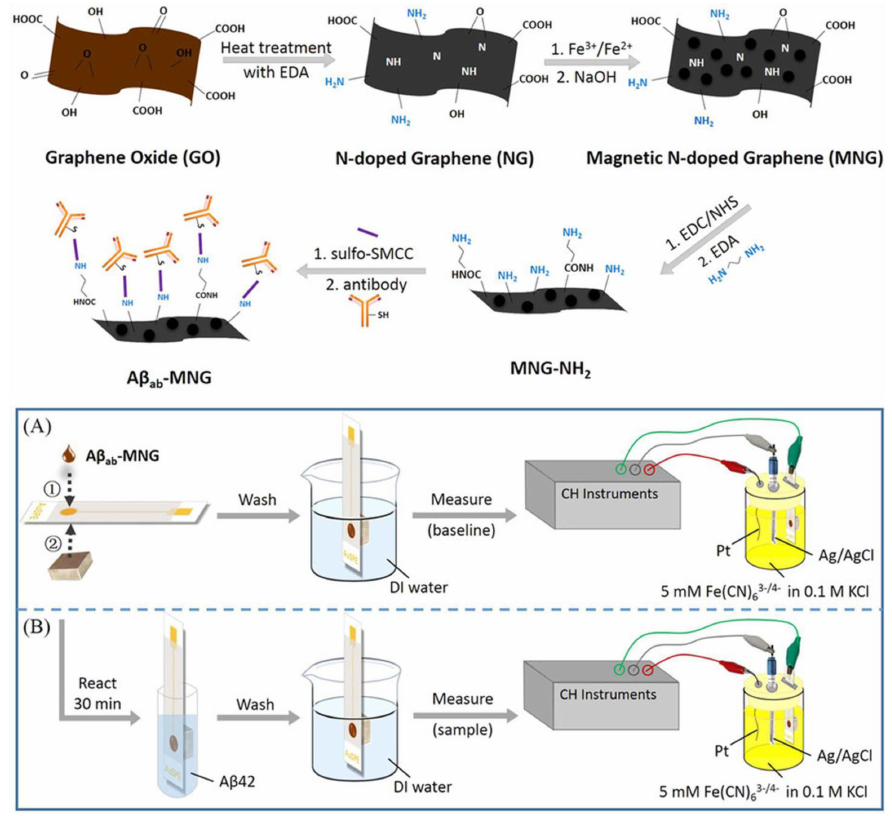
Figure 7. Graphical scheme representing preparation of magnetic immunoconjugates (A β ab -MNG), of the electrochemical detection by A β ab -MNG modified AuSPE ( A ) and the electrochemical detection of A β 42 using A β ab -MNG modified AuSPE ( B ). Reprinted from Ref. [84] with